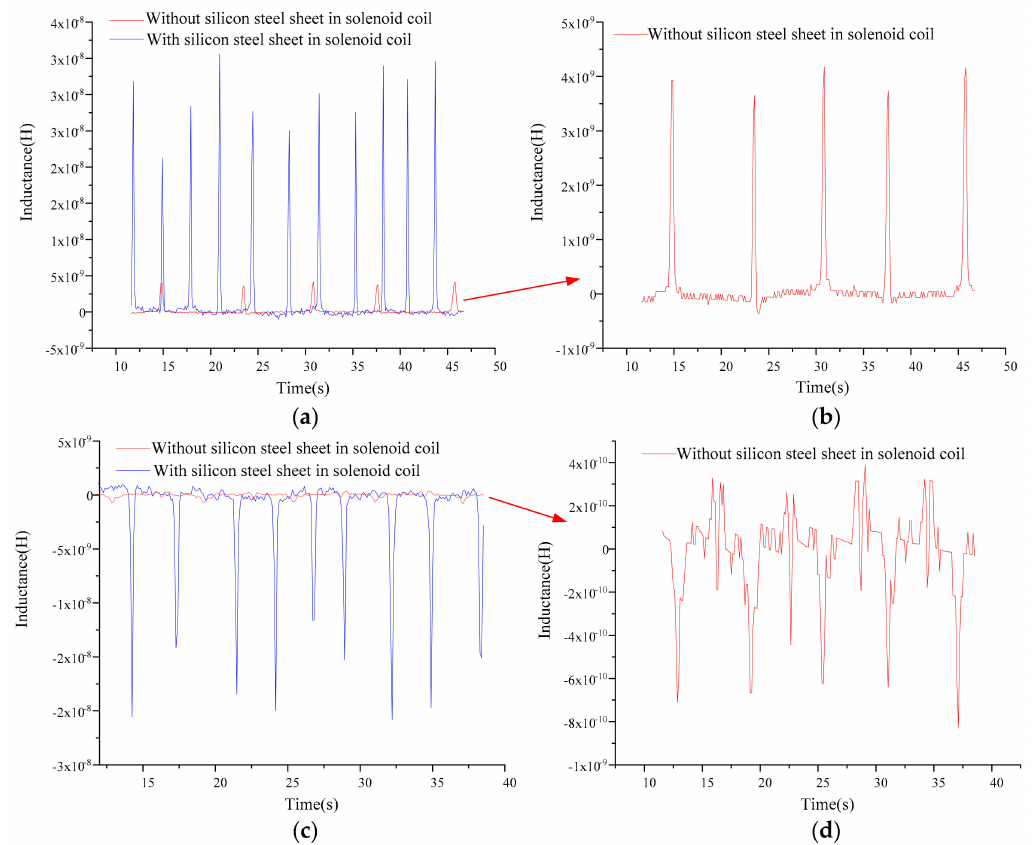
Figure 5. Inductance detection results of 120 to 130 µ m iron particles and 170 to 180 µ m copper particles: ( a ) iron particle detection results of the solenoid coils with silicon steel sheets; ( b ) iron particle detection results of the solenoid coils without silicon steel sheets; ( c ) copper particle detection results of the solenoid coils with silicon steel sheets; and ( d ) copper particle detection results of the solenoid coils without silicon steel